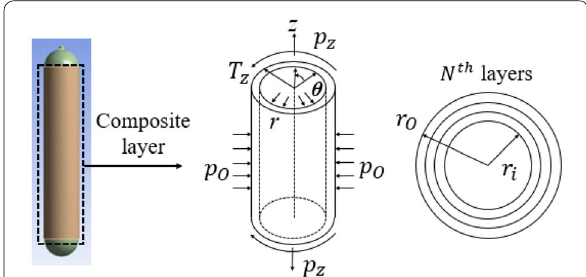
Figure 7 Mathematical model of multi-layered filament wound composite pressure